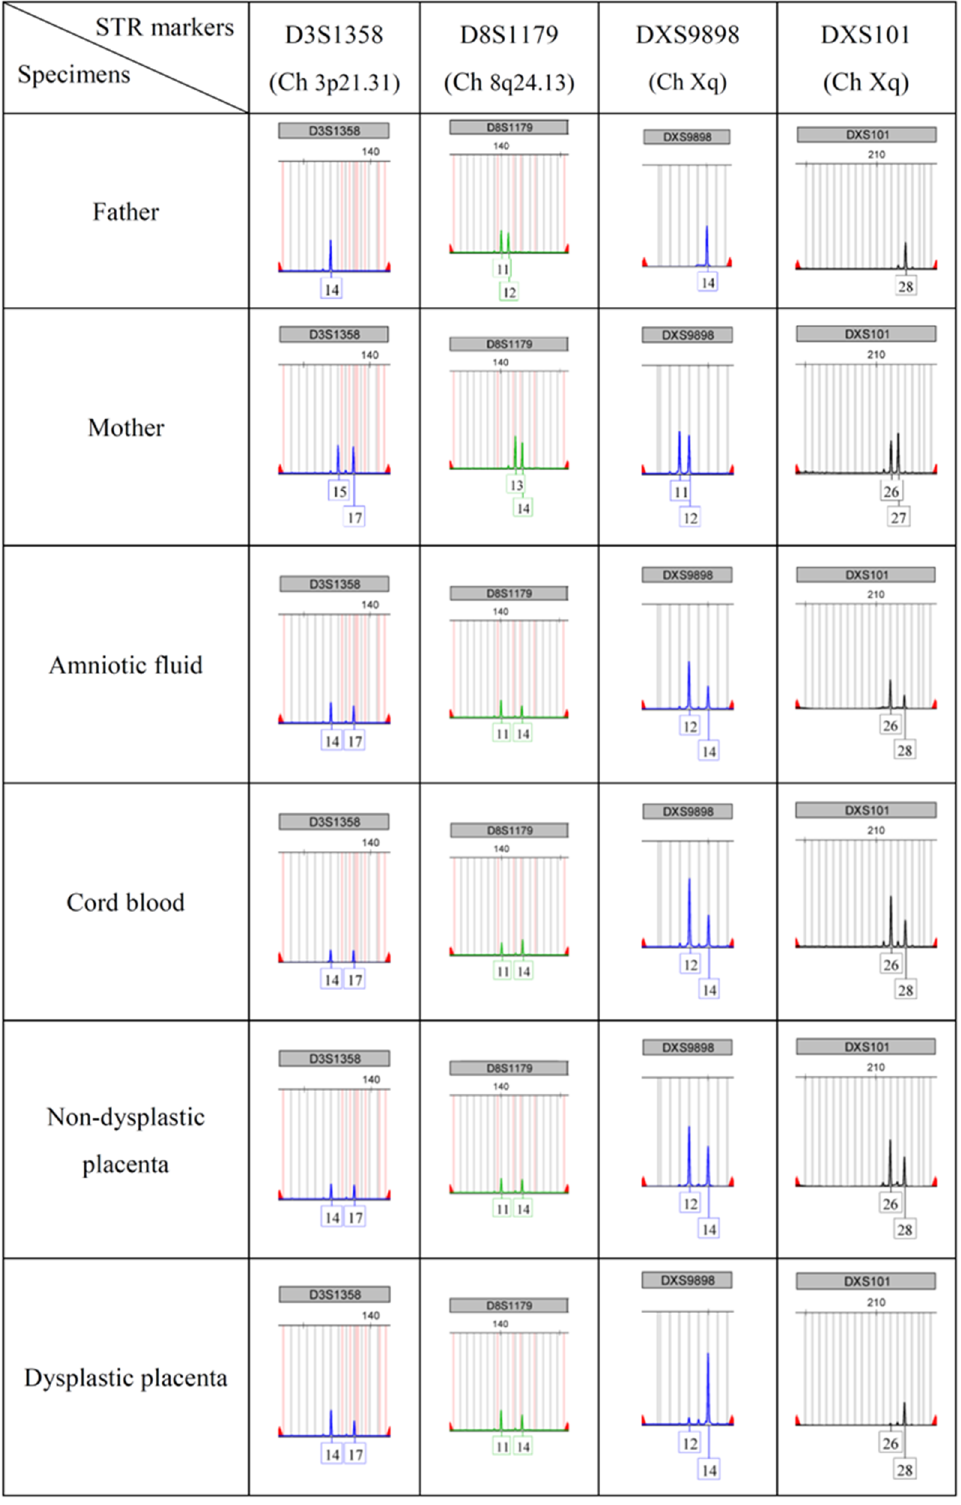
Figure 4. Short tandem repeat (STR) of blood of father, blood of mother, amniotic fluid, cord blood, non-dysplastic placenta and dysplastic placenta. All products of conception shared the same allelic signal.